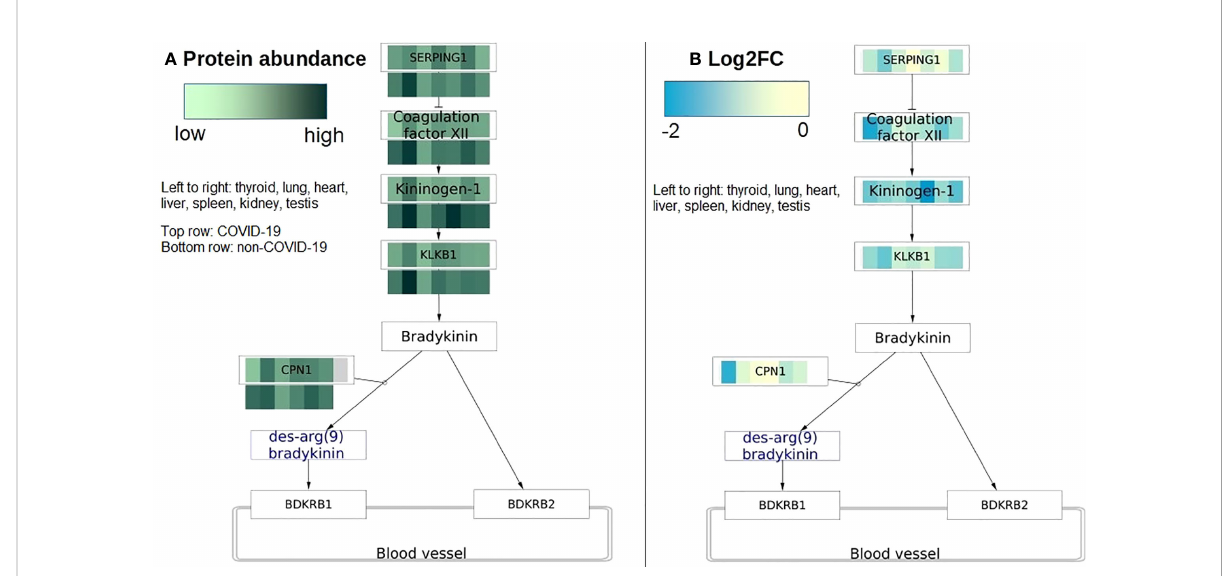
FIGURE 5 COVID-19 protein expression visualized on the Kinin Kallikrein pathway (WP5089). The pathway has activities changed in most tissues in COVID-19 patients. (A) Protein abundance is visualized on protein nodes in the pathway. Top row is data from COVID-19 patients and bottom row is data from non-COVID-19 patients. The higher the abundance the darker the value. The data nodes are split in seven columns for the seven different tissues. (B) The pathway fi gure shows the differential expression of the proteins (log2 fold change) between COVID-19 and non- COVID-19 patients. All proteins are downregulated or not changed in all tissues. The data nodes are split in seven columns for the seven different tissues. Left to right: thyroid, lung, heart, liver, spleen, kidney,